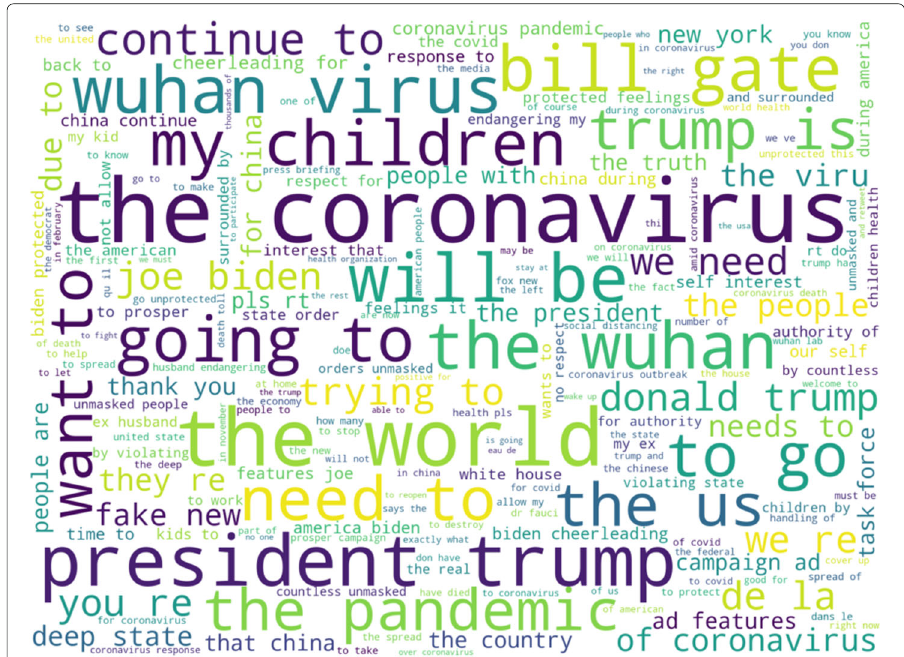
Fig. 15 Word map of the commonly used phrases and words from period 3 cluster 5, which consists of U.S. politics related hashtags. Much of the verbiage focuses on personalities, like President Donald Trump or